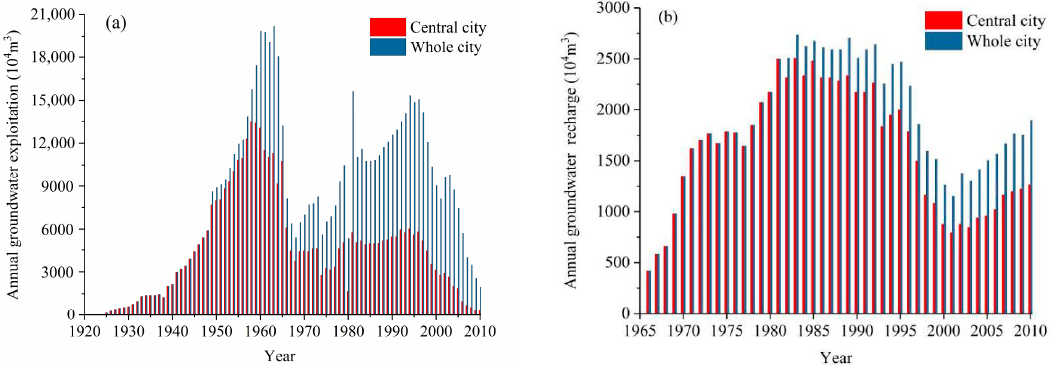
Figure 4. Changes in annual groundwater exploitation ( a ) and recharge ( b ) in Shanghai